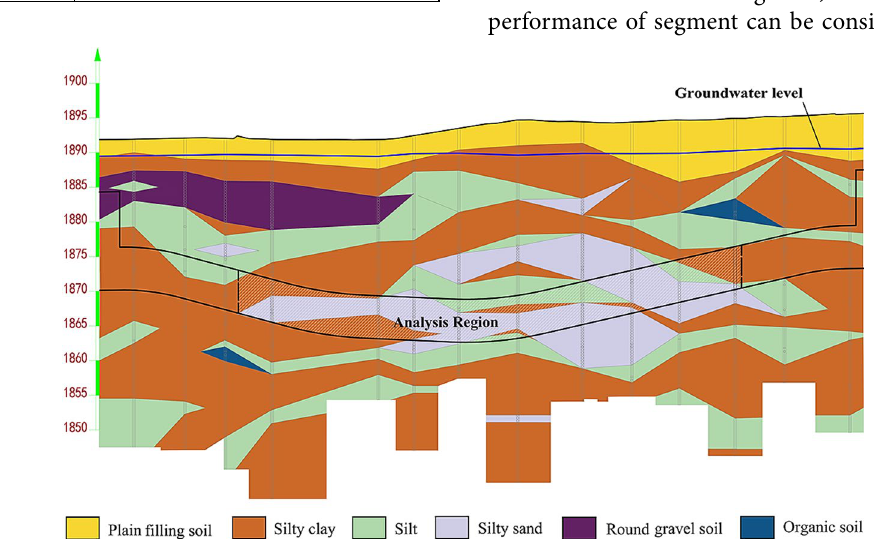
Figure 8. Longitudinal profile of the tunnel hydrogeology